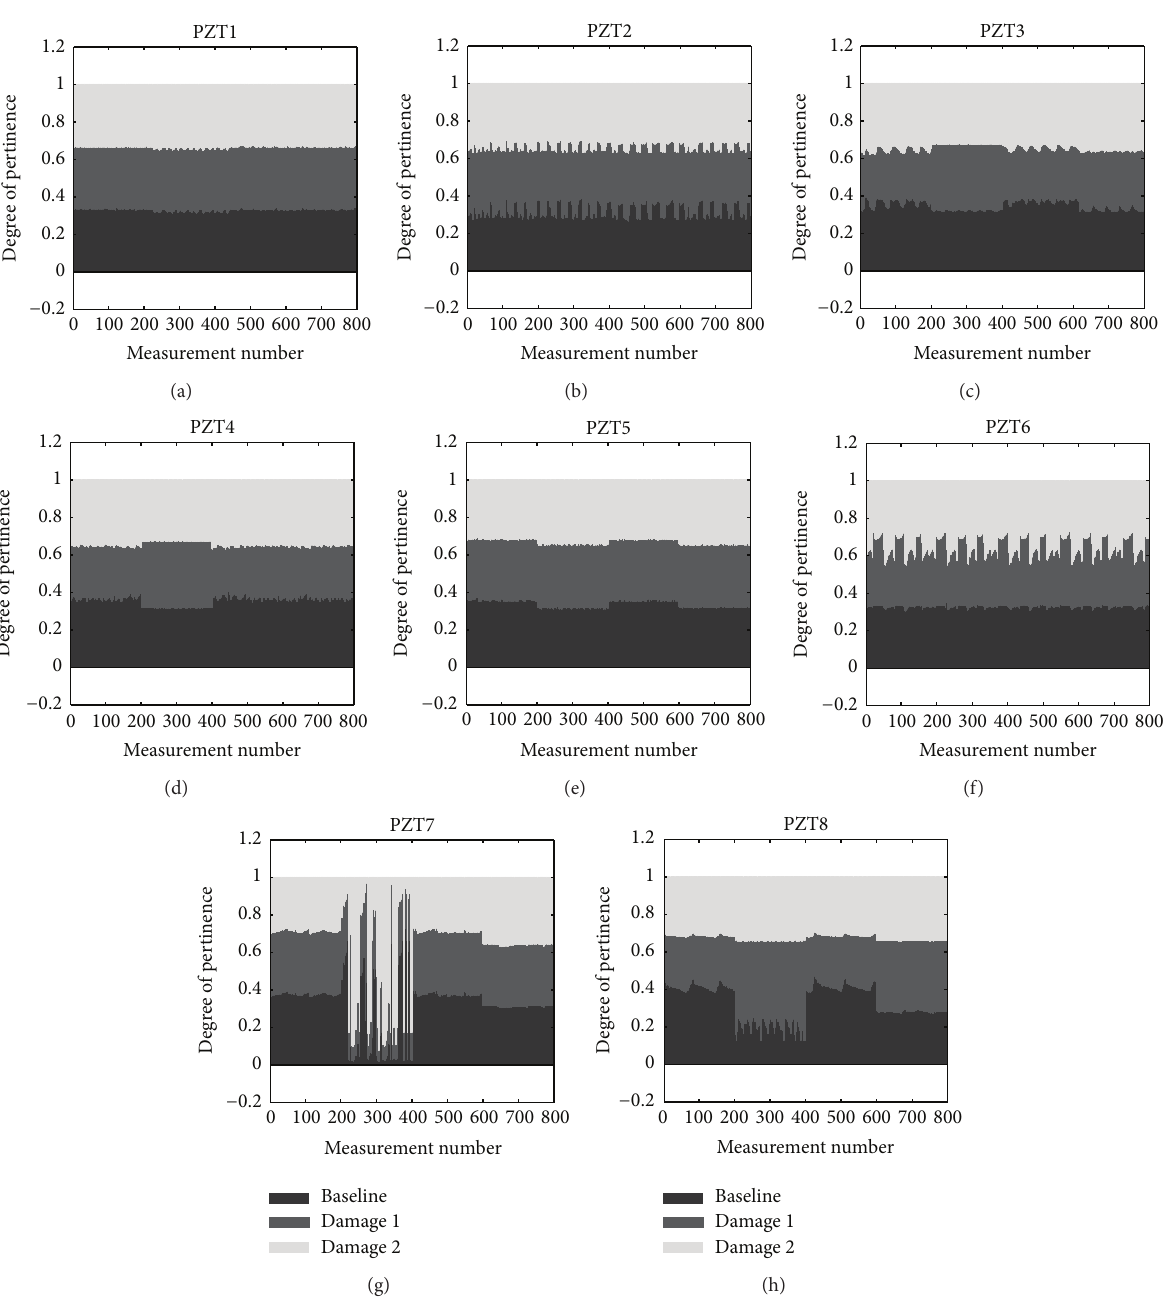
Figure 3: Initial degree of pertinence for aircraft panel. Table 2: Probabilistic neural network for damage